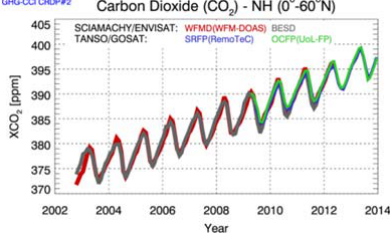
Fig. 1: GHG-CCI CRDP#2 XCO 2 Northern Hemisphere 2002- 2013 (see Tab. 1 for